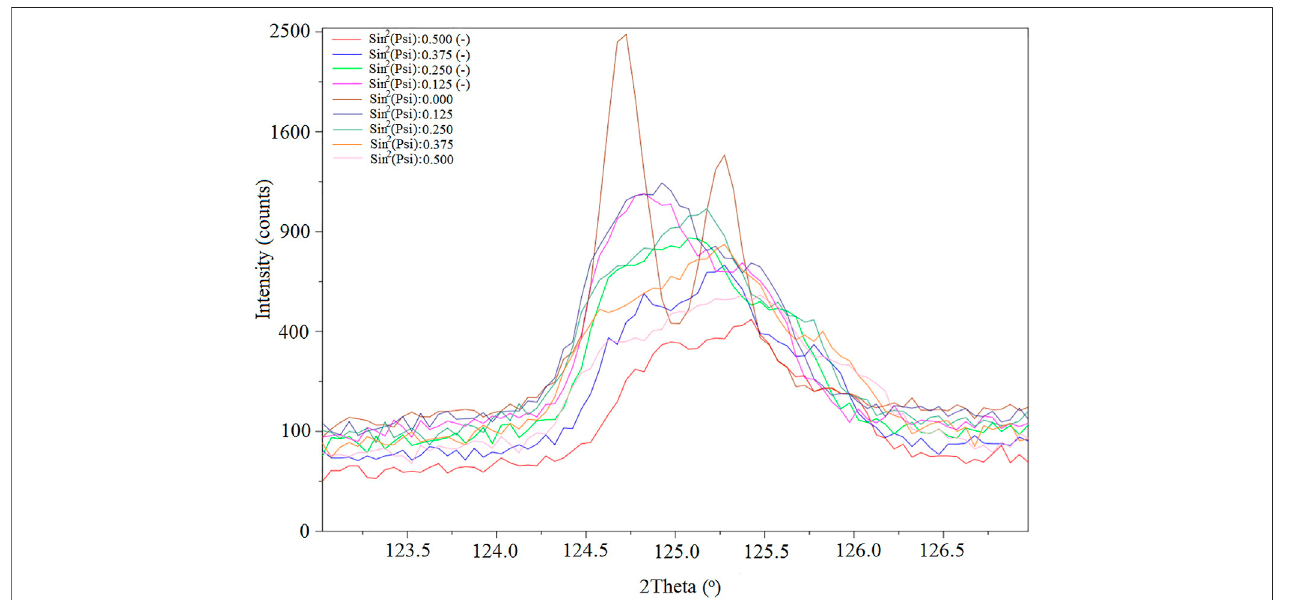
FIGURE 6 | Change of the diffraction peak of YSZ (5 3 0) plane with the change of ψ for the sample c3.